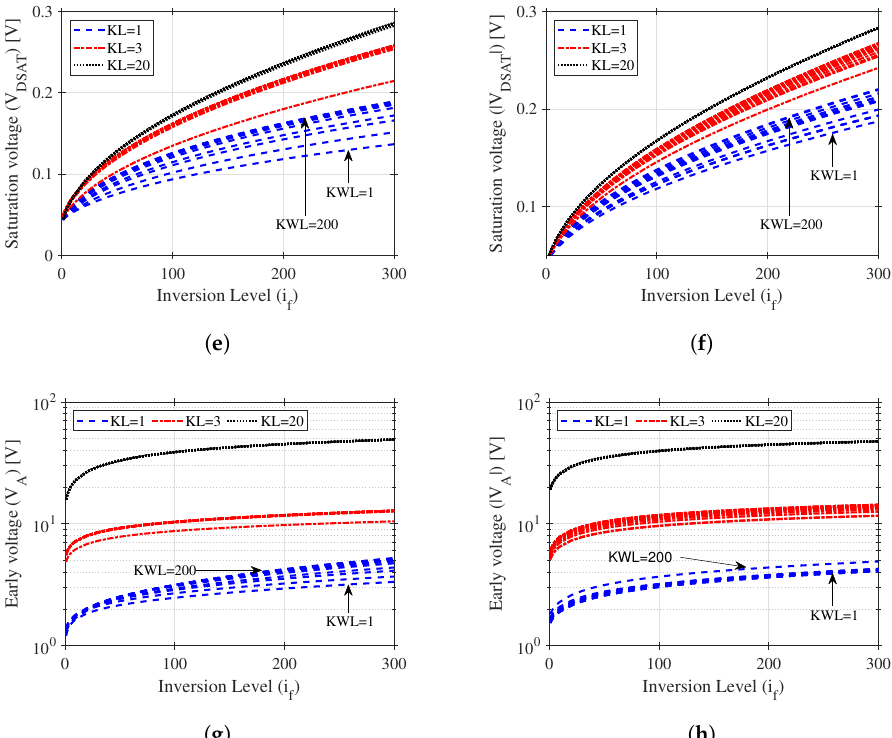
Figure 3. Sample of characterization data of a given CMOS technology in typical corner (TT) ( a )